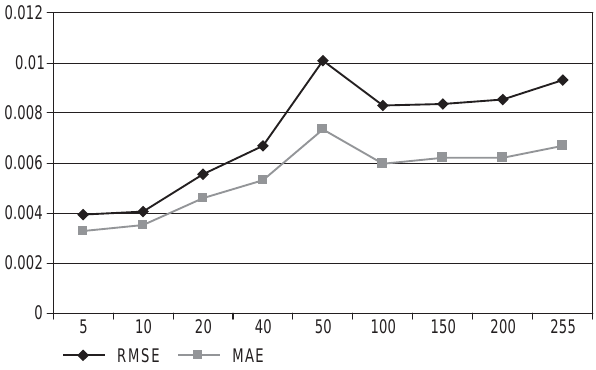
Fig. 6. RMSE and MAE dynamics over the forecast